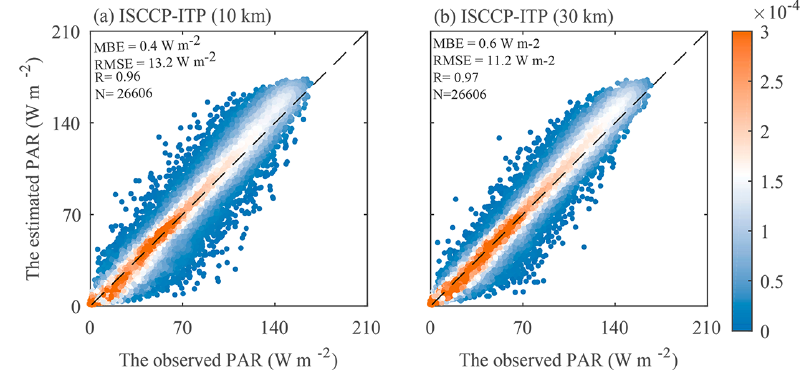
Figure 5. Comparisons of our estimated daily PAR product (ISCCP-ITP) at spatial resolutions of (a) 10km and (b) 30km with observed PAR collected at 7 SURFRAD stations.